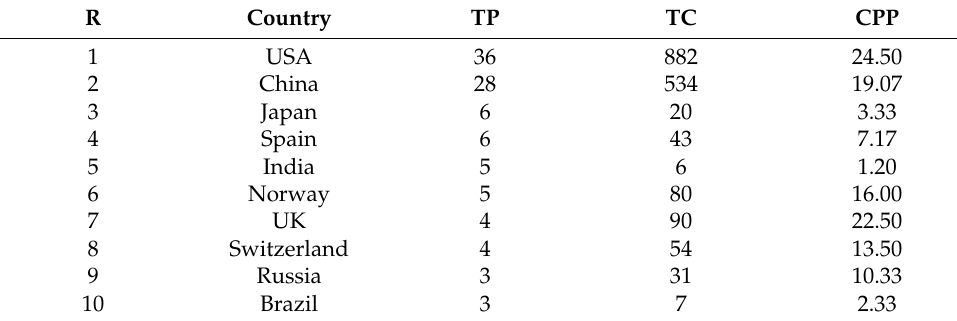
Table 9. Productive Country for